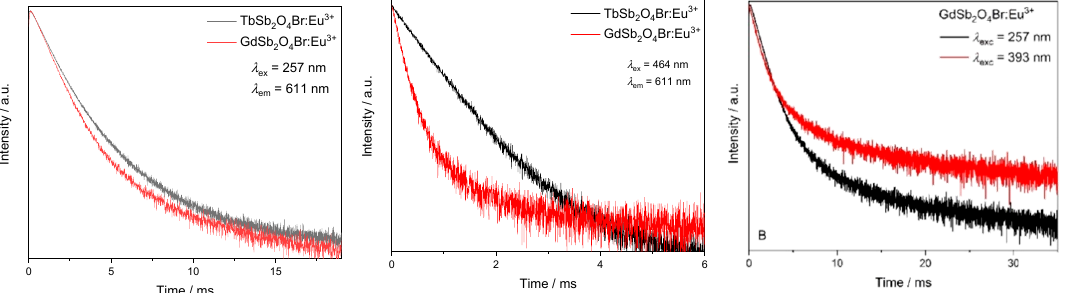
Figure 15. Lifetime comparison upon excitation at 257 nm between the Eu 3 + emission monitored at λ em = 611 nm in the different matrices (GdSb 2 O 4 Br and TbSb 2 O 4 Br, left ); upon excitation at 464 nm ( middle ); and for GdSb 2 O 4 Br:Eu 3 + upon excitation at λ ex = 257 nm and λ ex = 393 nm ( right ). All the intensity decays are reported on a logarithm (log) intensity scale.